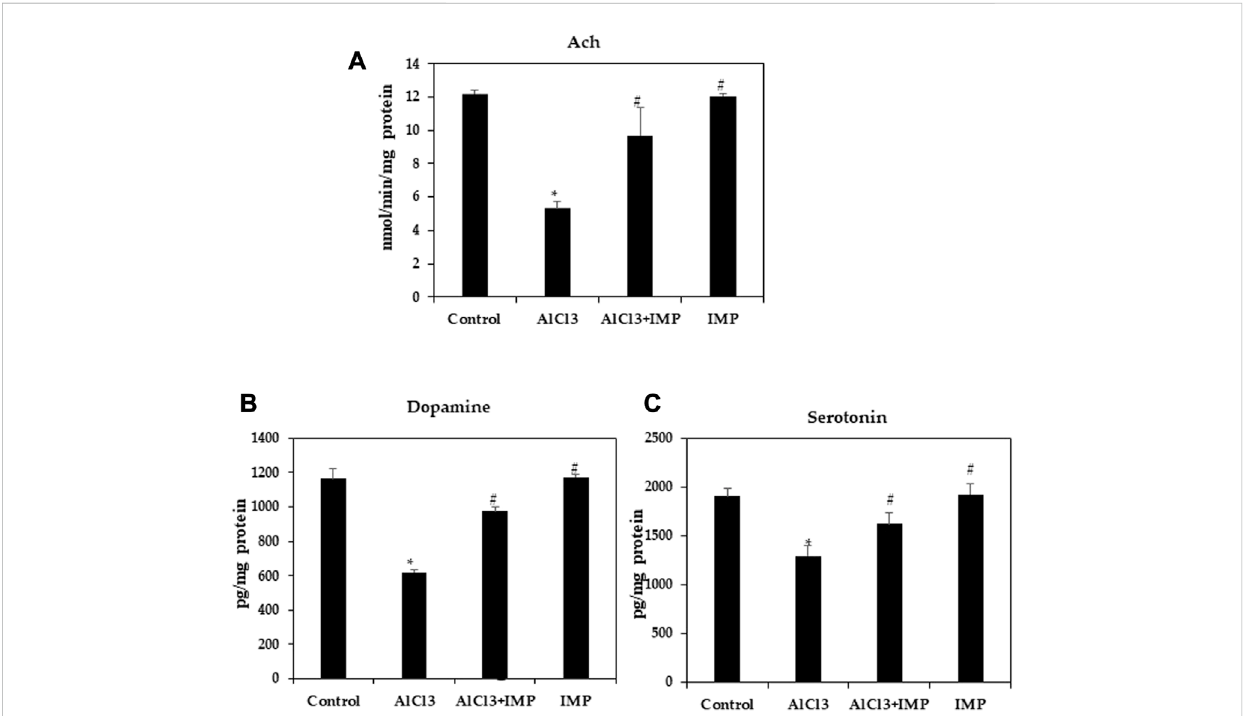
FIGURE 3 Effect of IMP on the level of Ach, Serotonin and Dopamine. (A) Level of acetylcholine concentration (nmol/min/mg protein). (B) Level of dopamine (pg/mg protein). (C) Level of serotonin (pg/mg protein). The difference between the treatment and control groups was statistically signi fi cant; * p < 0.05, # p < 0.05 was considered statistically signi fi cant. Values are expressed as mean ± SD, n = 3. * p < 0.05 indicates that there are signi fi cant differences between the AlCl3 alone group and the control group. # p < 0.05 shows signi fi cant differences between AlCl3 alone and IMP with